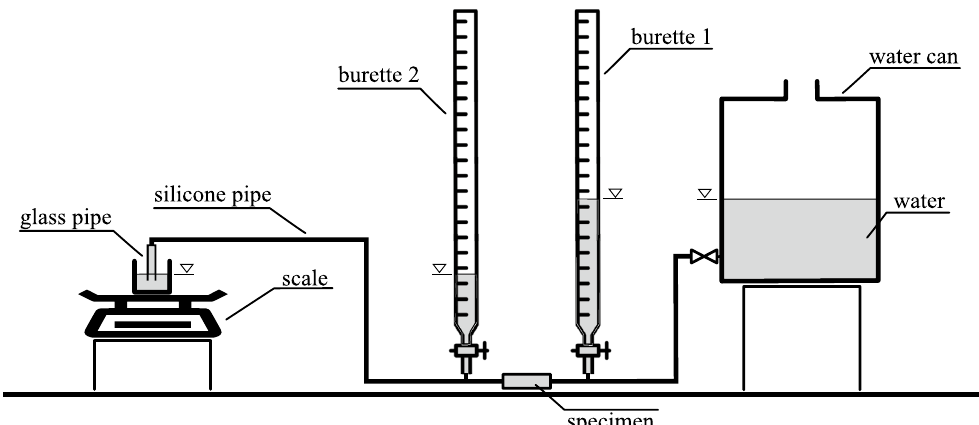
Figure 9. The schema of the saturated conductivity measurement laboratory setup (figure created using Inkscape 0.99 software https ://inksc ape.org/).